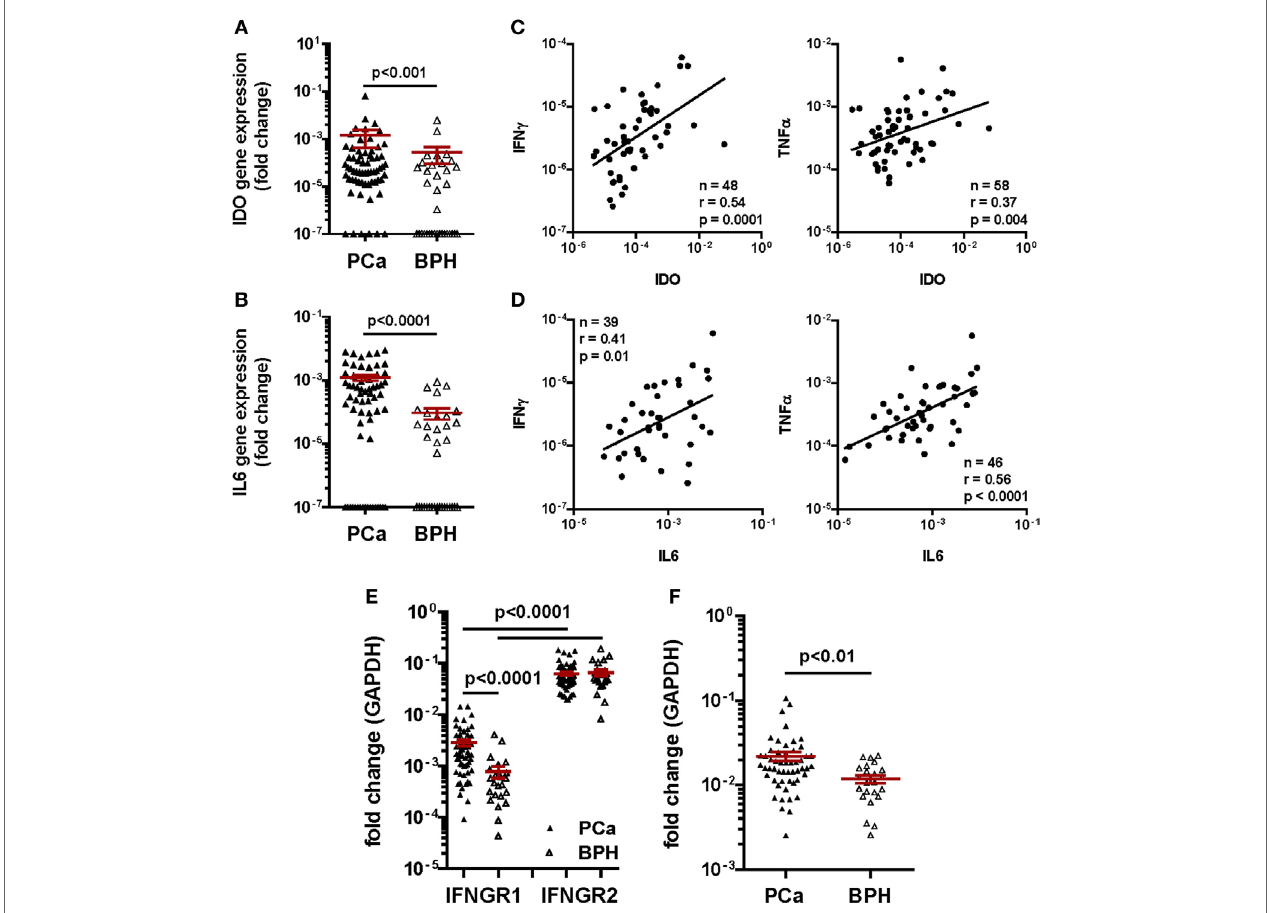
FigUre 5 | Gene expression profiling in clinical specimens. Gene expression of (a) Indoleamine 2,3-dioxygenase (IDO) and (B) interleukin (IL)-6 genes in prostate cancer (PCa) (black triangles) and benign prostatic hyperplasia (BPH) (open triangles). A higher expression of IDO and of both cytokine genes was detected in PCa than in BPH tissue specimens (Mann–Whitney U test; IDO p < 0.001, IL-6 p < 0.0001). The 2 −ΔΔ Ct method was used to compute fold changes in gene expression for both cytokines, setting GAPDH gene expression equal to 1. Values ≤ 10 7 were considered undetectable. (c,D) Fold